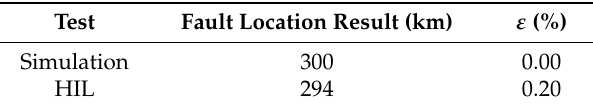
Table 6. AB fault location results of simulation and HIL test.